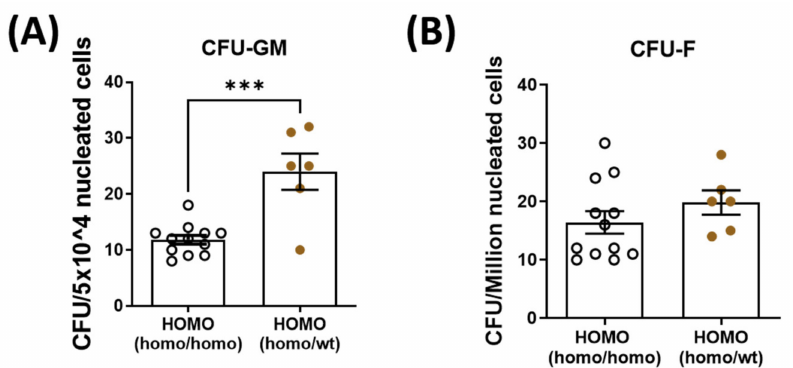
Figure 4. Quantification of bone marrow hematopoietic stem cells (CFU-GM) and mesenchymal stem cells (CFU-F) isolated from the bone marrow. Bone marrow hematopoietic stem cells and mesenchymal stem cells were isolated and quantified from the contralateral tibia. ( A ): Hematopoietic stem cell quantity was significantly increased in the dKO-homo mice after paired with WT